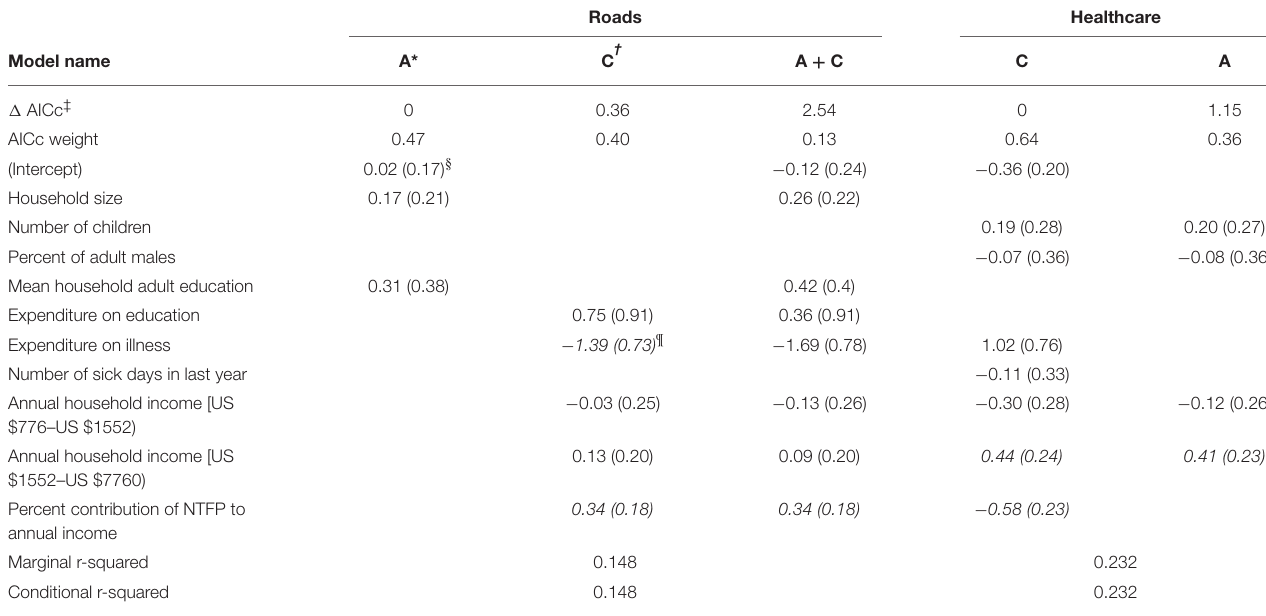
TABLE 2 | Top-ranked models (cumulative weight > 0.95) and beta estimates of fixed effects for predicting the likelihood that households want to relocate for better access to roads, and healthcare facilities at Kawal Tiger